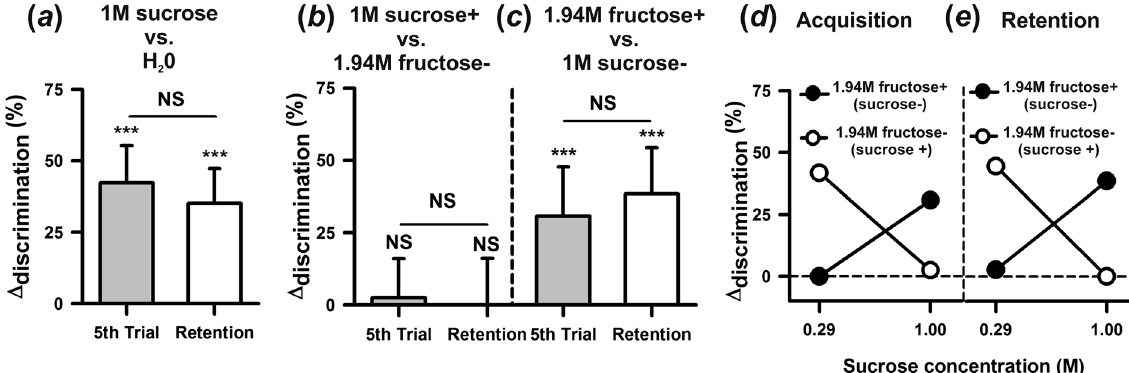
Figure 3. Sweetener perception and discrimination in honeybees. ( a ) Discrimination learning of 1 M sucrose vs. distilled water. Δ discrimination values reached in the last conditioning trial and in the retention test. Bees ( n = 71) learned the discrimination and remembered it 1 h later. ( b ) Discrimination learning between sweeteners, 1 M sucrose ( + ) and 1.94 M fructose ( − ). Δ discrimination values reached in the last conditioning trial and in the retention test when 1 M was sucrose punished ( + ) and 1.94 M fructose was unpunished ( − ) ( n = 40). Bees, which prefer the former to the latter, were unable to learn the difference between these two sweet tastants and therefore showed no retention 1 h after conditioning. ( c ) Discrimination learning between 1.94 M fructose ( + ) and 1 M sucrose ( − ). Δ discrimination values reached in the last conditioning trial and in the retention test after differential conditioning when 1.94 M fructose was punished ( + ) and 1 M sucrose was unpunished ( n = 39). In this case, bees learned efficiently the difference between the two sweet solutions and remembered it 1 h later. ( d ) Asymmetry in sweetener discrimination learning. Δ discrimination values in the last conditioning trial as a function of variable sucrose concentration. The concentration of fructose solution was constant (1.94 M). Values for 1 M sucrose correspond to those reported in ( b ) and ( c ) (gray bars). When sucrose concentration was devaluated so that fructose became more attractive, the asymmetry in sweetener discrimination was reversed. ( e ) Asymmetry in sweetener retention. Same as in ( d ) but for retention performances. NS: non-significant; *** P < 0.0001. Error bars on Δ disc levels represent 95% confidence